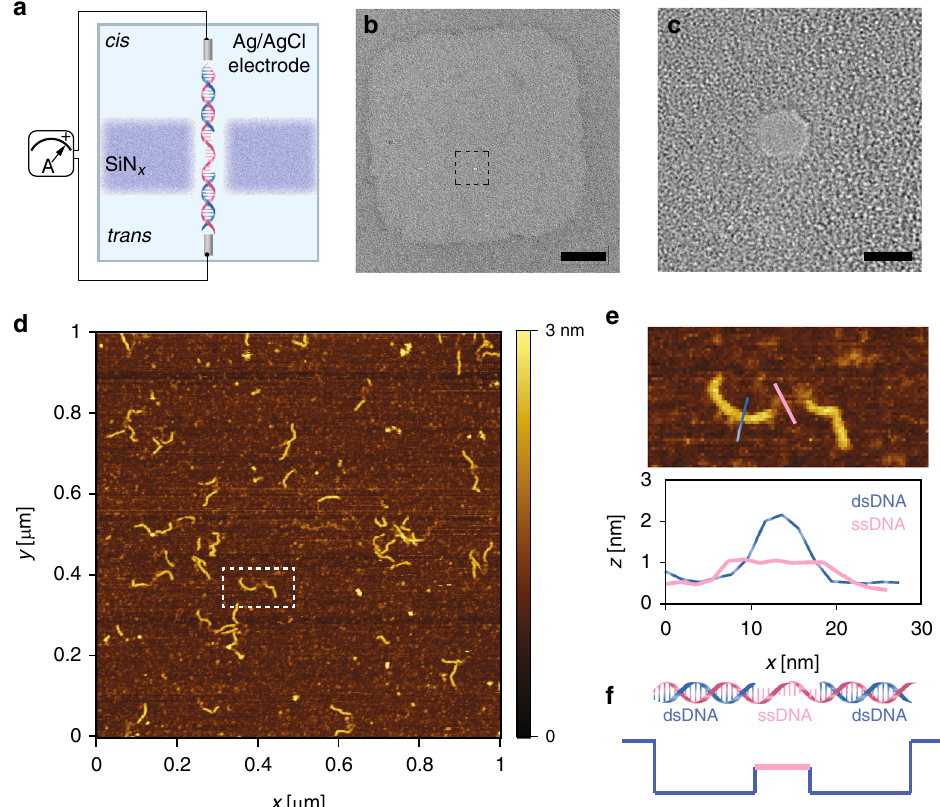
Fig. 1 a A schematic illustration of a nanopore membrane, where a programmed DNA passes through a nanopore in the SiN x membrane. The device is mounted between two reservoirs fi lled with a saline solution and connected to a current-to-voltage ampli fi er to induce a transmembrane bias across the membrane. b A low-magni fi cation TEM bright- fi eld image shows the locally thinned region on the SiN x membrane. The nanopore is marked by the black square. Scale bar is 50 nm. c A high-magni fi cation TEM bright- fi eld image presents a single 2.5 nm nanopore, which is slightly larger than the